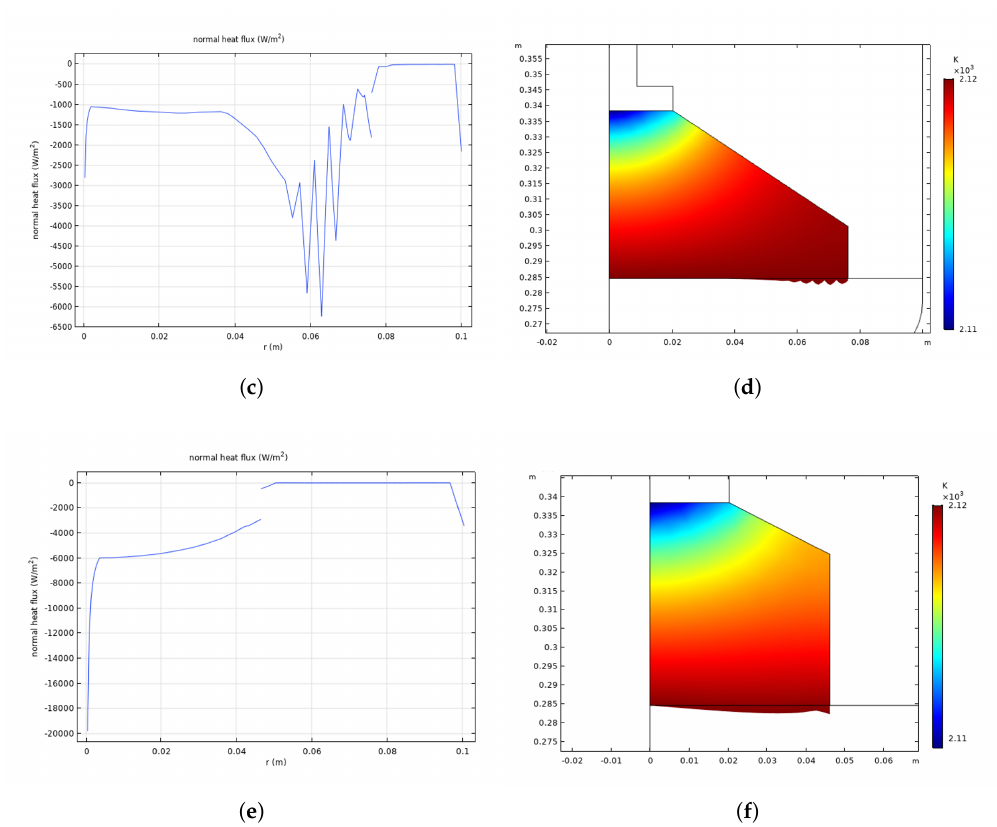
Figure 7. Heat flux across the six-inch crystal interface before pulling at equilibrium ( a ) and during pulling at 300 s ( b ) and at 19,000 s ( c ), and temperature across the crystal–melt interface at 19,000 s ( d ); heat flux across the four-inch crystal interface at 6000 s ( e ) and temperature across the crystal–melt interface at 6000 s ( f